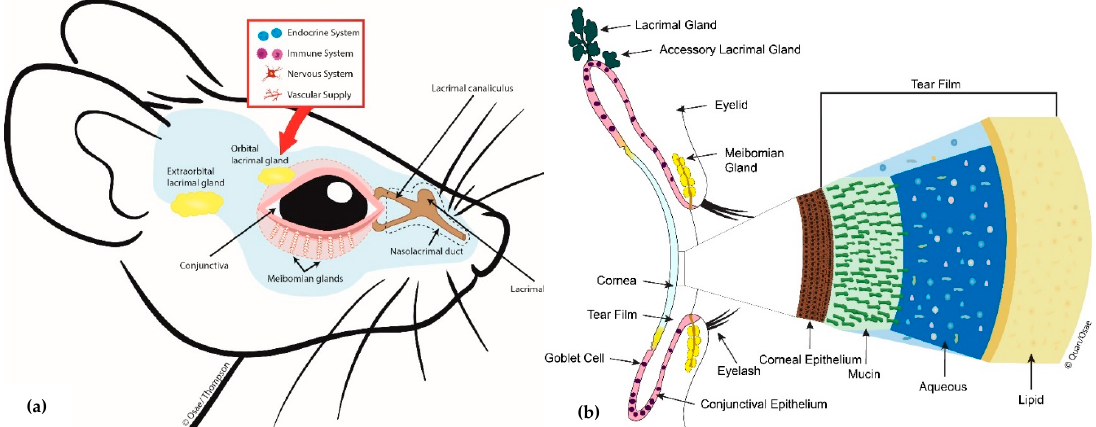
Figure 1. Diagram showing ( a ) mouse meibomian glands (lower eyelid only) and related ocular surface structures and ( b ) a cross-sectional view of some key lacrimal functional unit (LFU) components, the tear film components including the outermost lipid produced by the meibomian gland (MG) and how it interacts with the corneal surface.